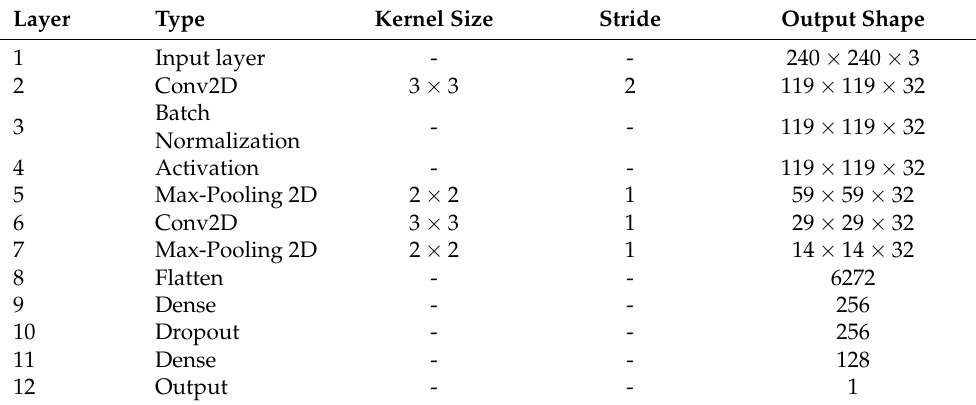
Table 2. Summary of the proposed